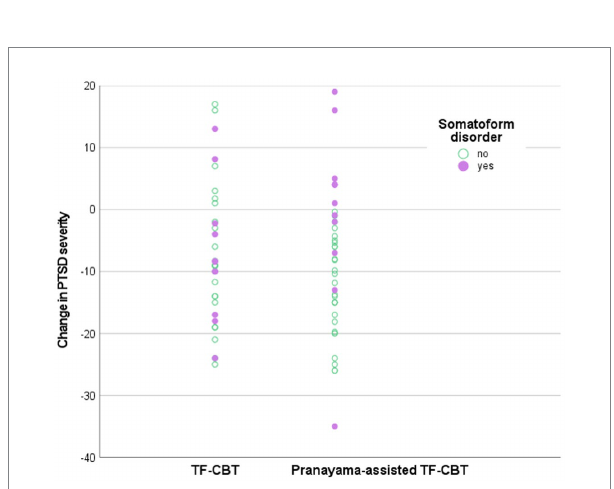
FIGURE 3 Scatterplot of the moderation analysis. PTSD = Post-traumatic stress disorder, TF-CBT = Trauma-focused cognitive behavioral